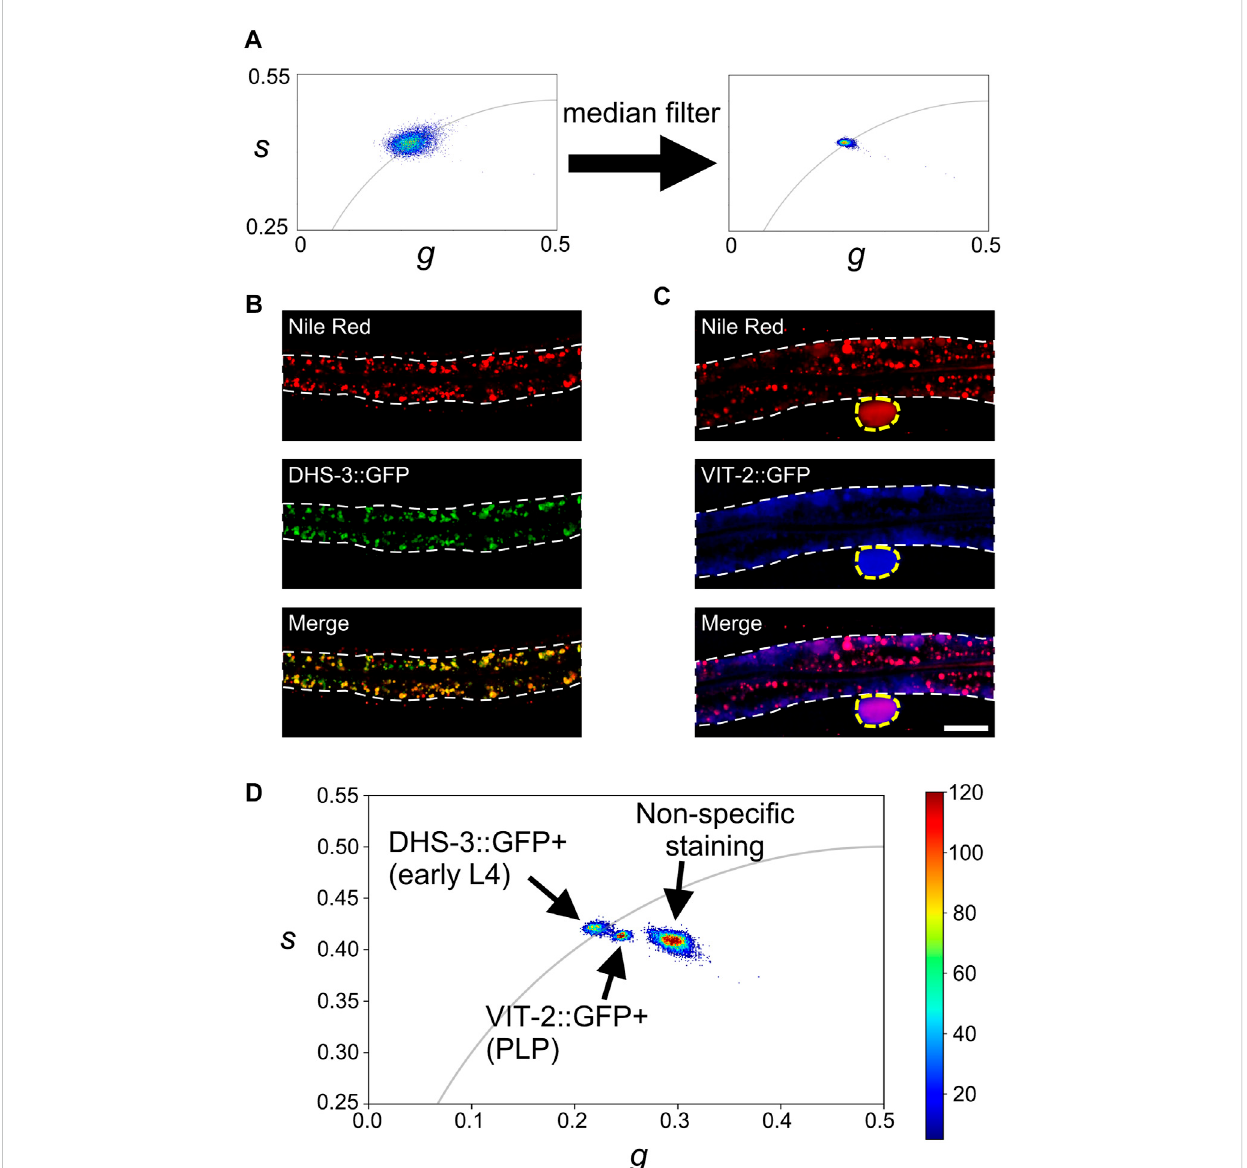
FIGURE 2 PhasoranalysisofNileRed2p-FLIMsignals. (A) ThepixelFLIMphasorplotsbeforeandafterapplyingamedian fi lterto s and g images. (B , C) TheNile Red (upper), GFP (middle), and merge (lower) images of a DHS-3::GFP transgenic early L4 worm and a VIT-2::GFP transgenic adult worm, respectively. The white dash lines indicate the intestine, and the yellow dash line in (C) indicates the pseudocoelomic lipoprotein particle (PLP) that is used for the phasor analysis. Scale bar, 20 μ m. (D) The phasor plot of Nile Red signal in the DHS-3::GFP-positive (in early L4 worms), VIT-2::GFP-positive (PLP), and non-speci fi c staining (low-concentration Nile Red vital staining of wild-type adult worms) regions. The universal semicircle (in gray) indicates the single-component lifetimes that can be fi tted with single exponential decay curves. The color bar represents pixel